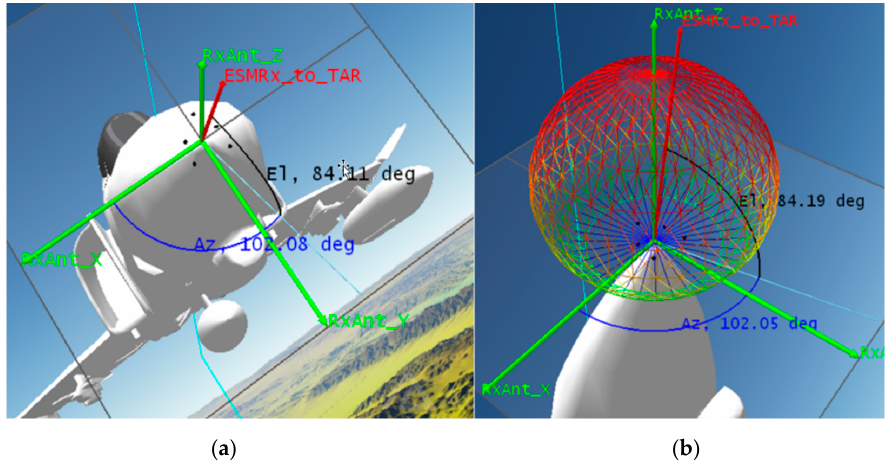
Figure 9. ( a ) 6-element RESM RX array and array local coordinate system, ( b ) an example of the first CBSA element radiation pattern.